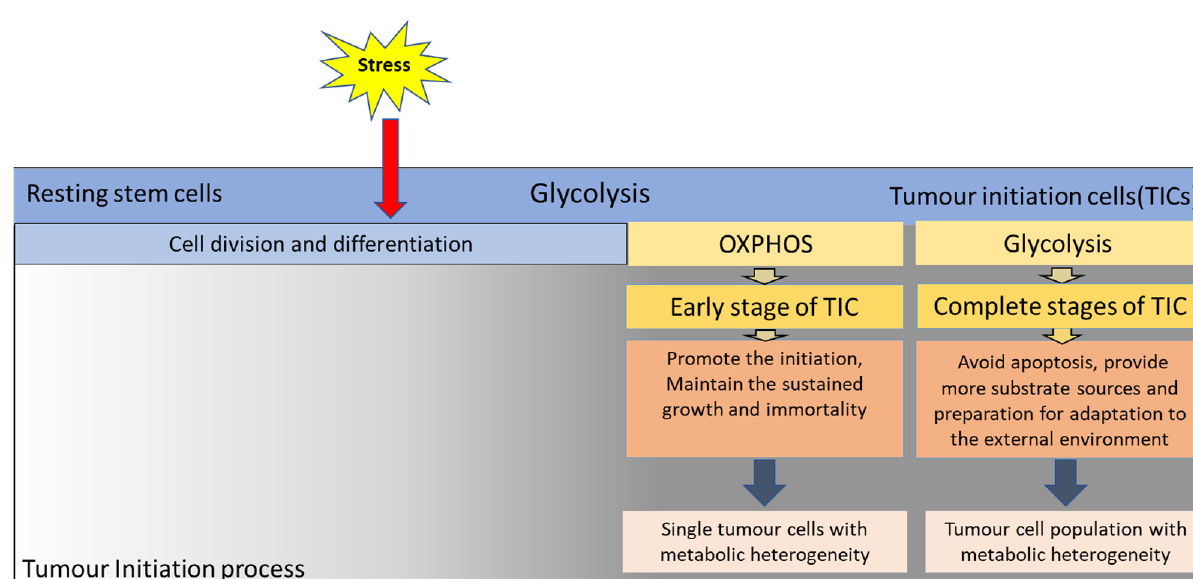
Figure 1. Influence of metabolic plasticity regulation on tumour initiation. Compared with other periods, stem cells at the resting stage (resting stem cells) are more susceptible to external stimuli during division and differentiation, resulting in increased gene instability, tumorigenesis initiation, and appearance of TICs. At the same time, mitochondrial OXPHOS may exist in the early stage, that is, for the immortalization and further transformation of TIC by promoting aspartate synthesis and subsequent nucleotide metabolism and other biochemical reactions. Glycolysis has essential roles during tumour initiation and affects the entire TIC stage, which is necessary for tumour